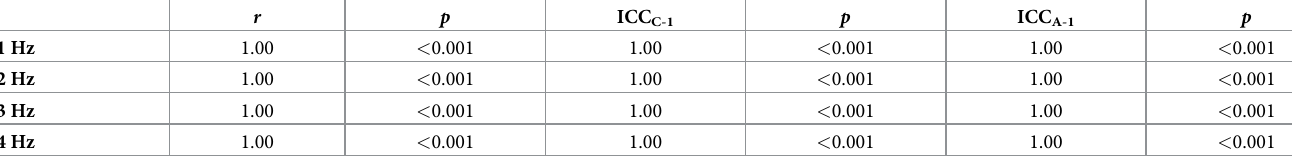
Table 2. Statistical results for correlational analyses of pose estimation vs. manual identification of hand closures.